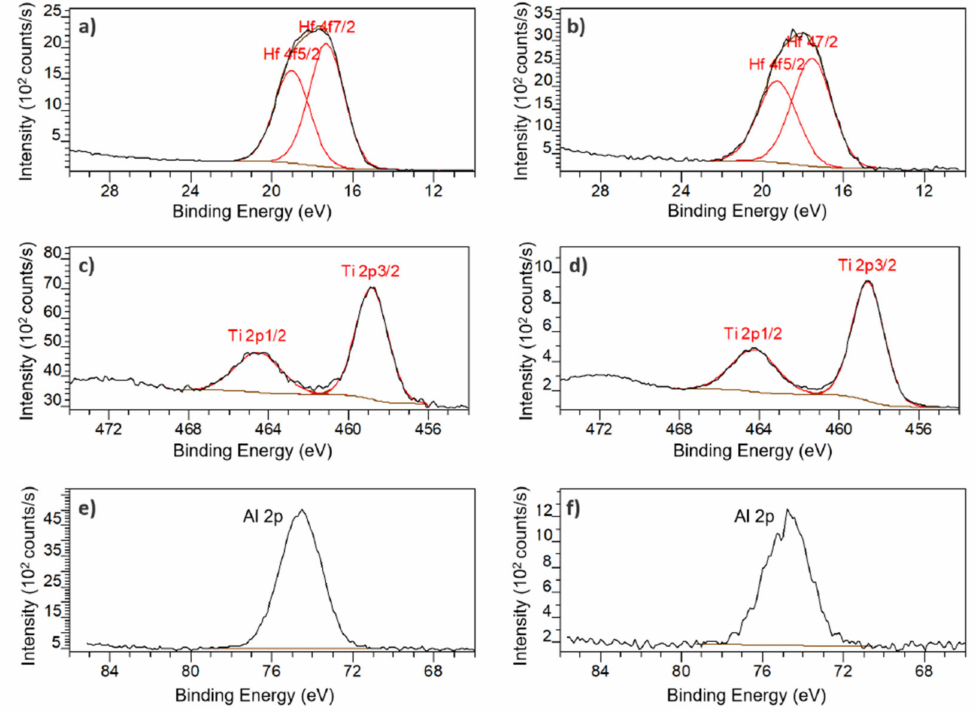
Figure 7. High resolution XPS core level spectra: Hf 4f on PSiO 2 /HfO 2 membrane ( a ) front, and ( b ) back; Ti 2p on PSiO 2 /TiO 2 membrane ( c ) front and ( d ) back; Al 2p on PSiO 2 /Al 2 O 3 membrane ( e ) front and ( f )